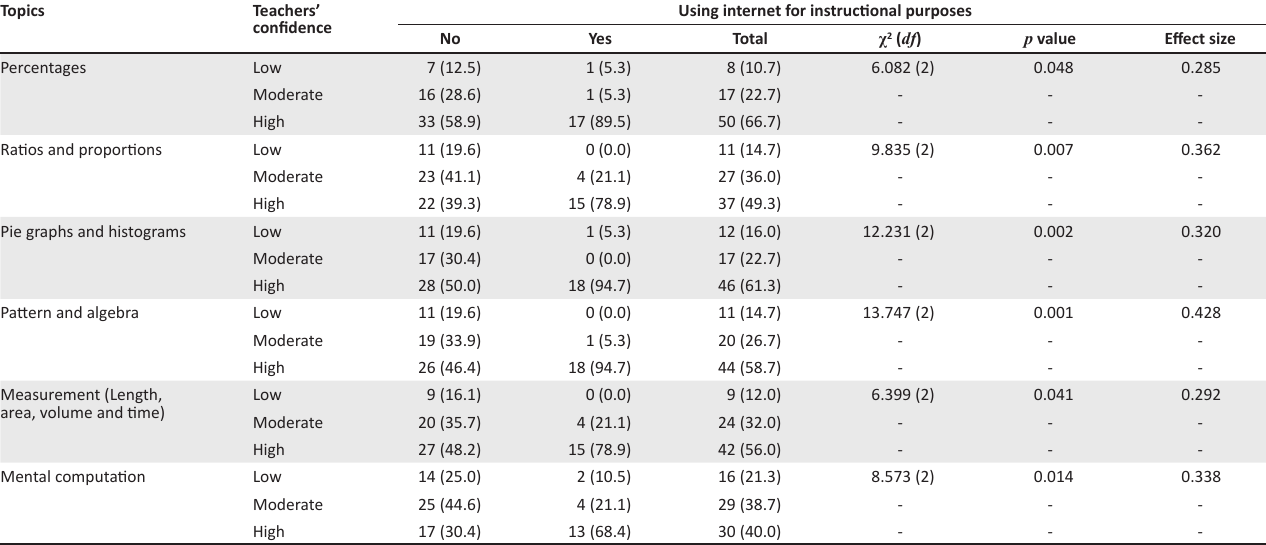
TABLE 5: Using internet for instructional purposes and teachers’ confidence.